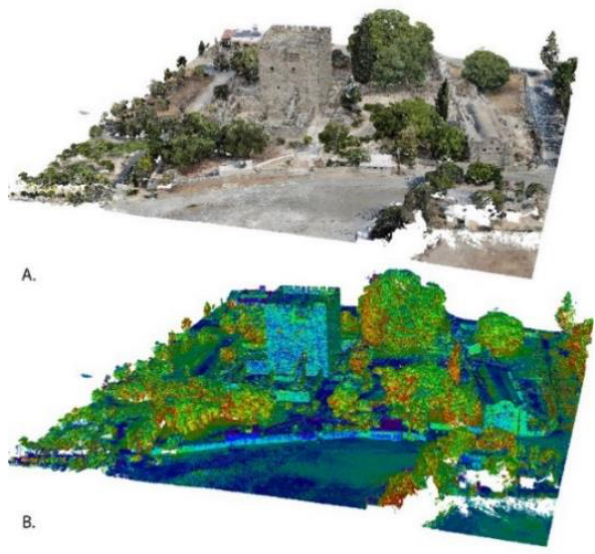
Figure 4. Kolossi pointcloud registered. A. Pointcloud with true RGB colour and B. Pointcloud displayed by intensity for i.e material documentation/specification.